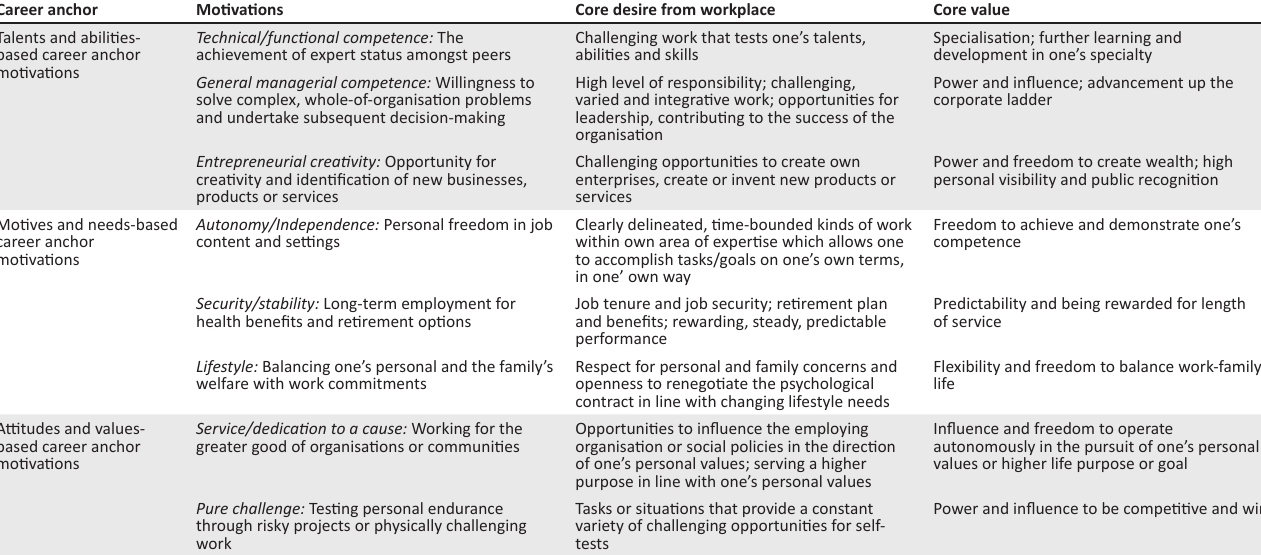
TABLE 1: Core workplace desires and values underlying people’s career